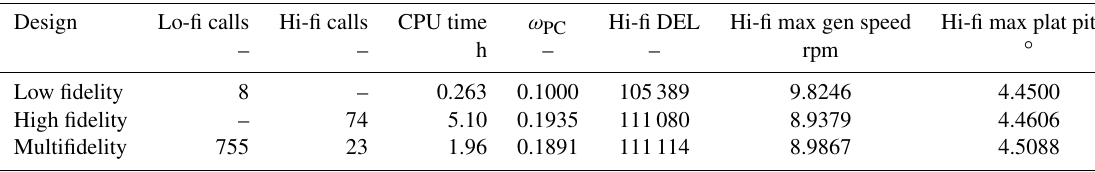
Figure 8. The linearized and nonlinear functions of interest as we vary the pitch controller bandwidth, ω PC . Table 4. Optimal results for the controls